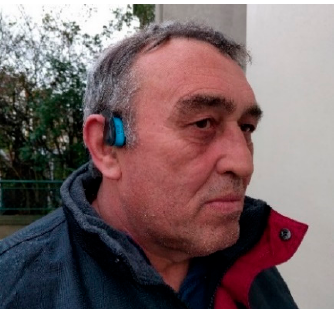
Figure 2. Participant wearing the bone conduction headphones.